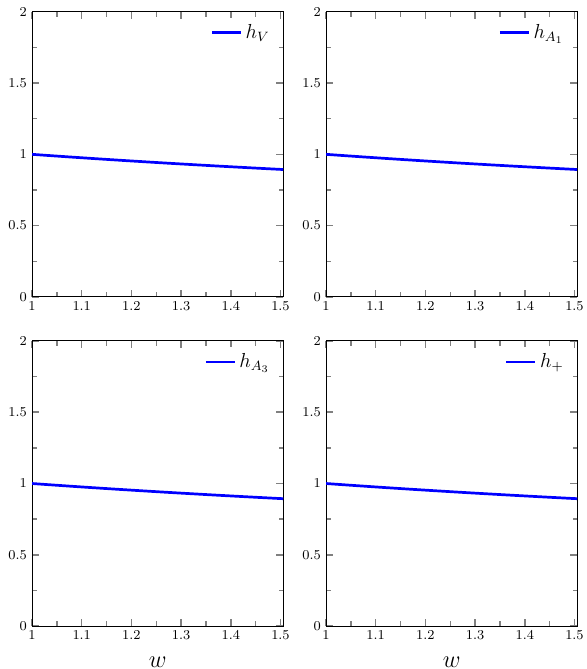
Fig. 7 h + , h A to 1 at w =